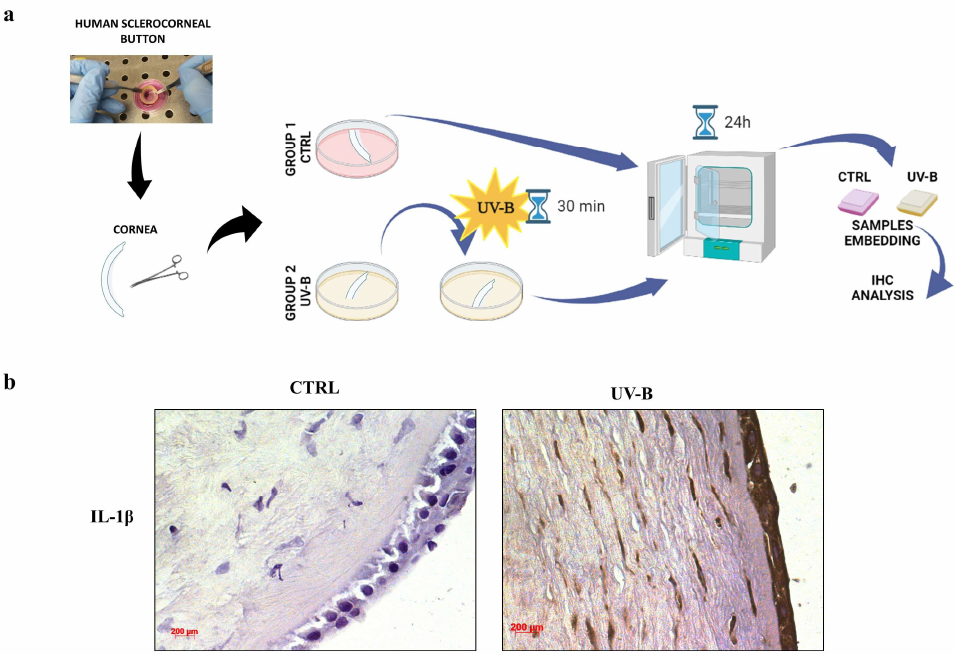
Figure 1. Effect of UV-B rays on IL-1β expression using an ex vivo human cornea model. ( a ) Image showing the experimental design for UV-B irradiation experiments. ( b ) Immunodetection of IL-1β in human cornea not (CTRL) or subjected to UV-B exposure (UV-B). Digital micrographs are representative results of fields taken in randomly selected slides and obtained using the Zeiss Axioplan light microscope (Carl Zeiss, Oberkochen, Germany) fitted with a digital camera (AxioCam MRc5; Carl Zeiss). Scale bar: 200 µm.